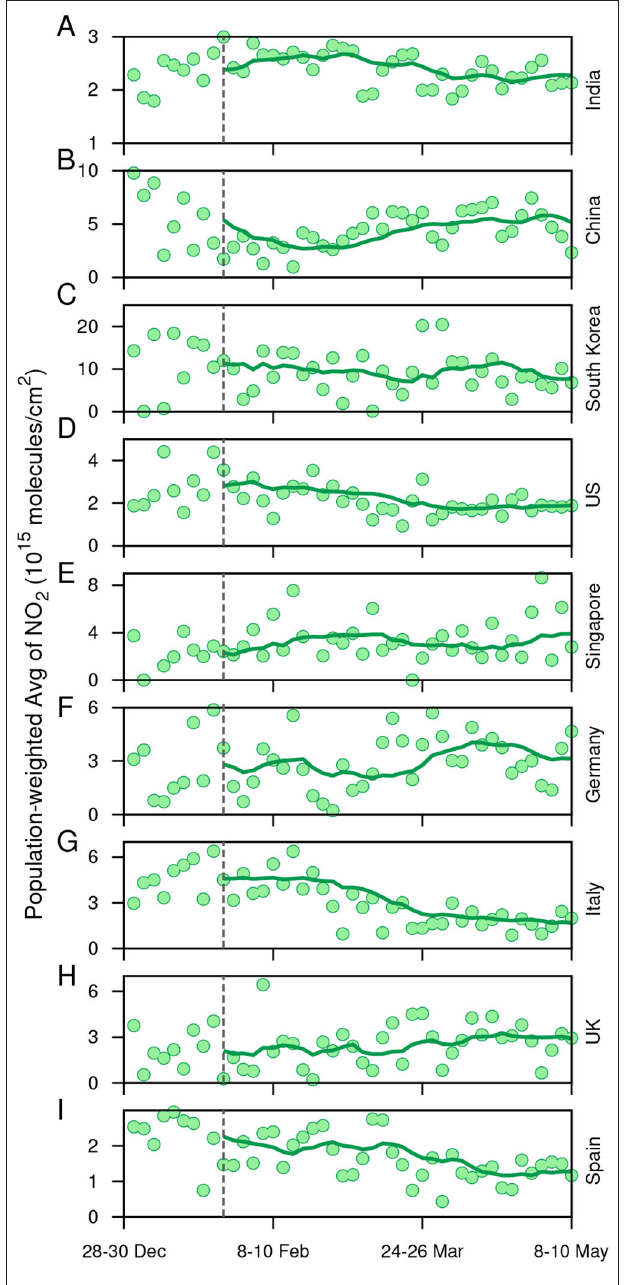
FIGURE 7 | (A-I) : Time series of triads of the population-weighted total-column NO 2 (molecules/cm 2 ) density over the length of the study period for the nine countries considered in this work (depicted by the circular points). The solid curve in each subfigure represents a 10-triad moving window average of the time